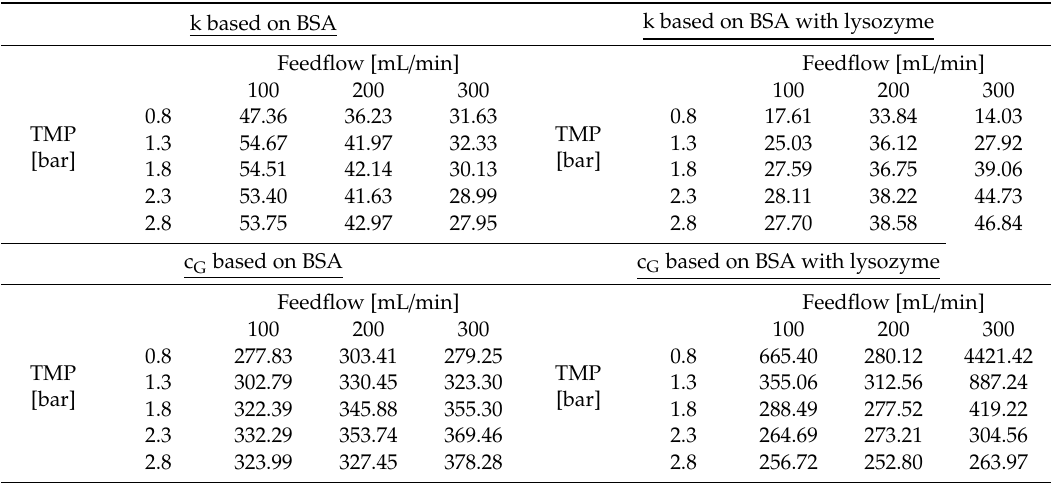
Table A5. Mass transfer coe ffi cient k and gel concentration c G for SFM based on BSA (left) and BSA with lysozyme (right).